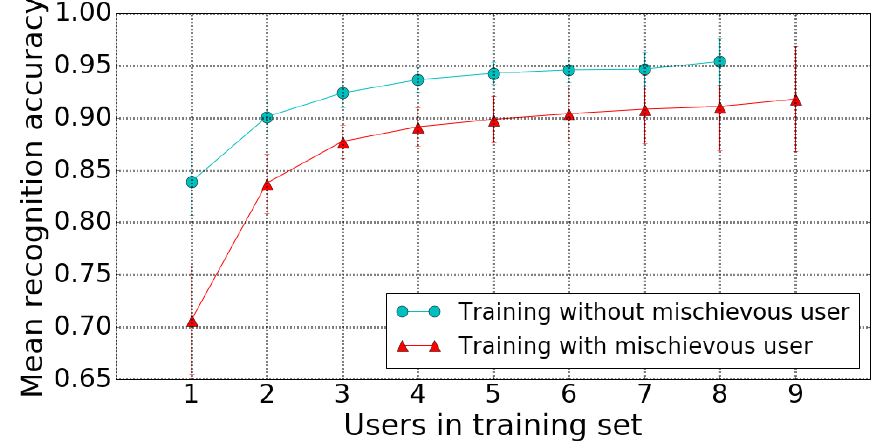
Figure 4. Mean accuracy vs. number of users in training set, with/without the mischievous user.